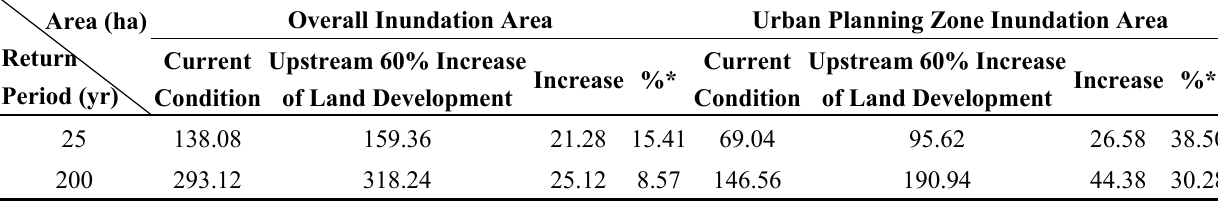
Table 8. 25- and 200-year return periods: Inundation area of current land use conditions vs. 60% Increase of the overall region vs. the urban planning zone.